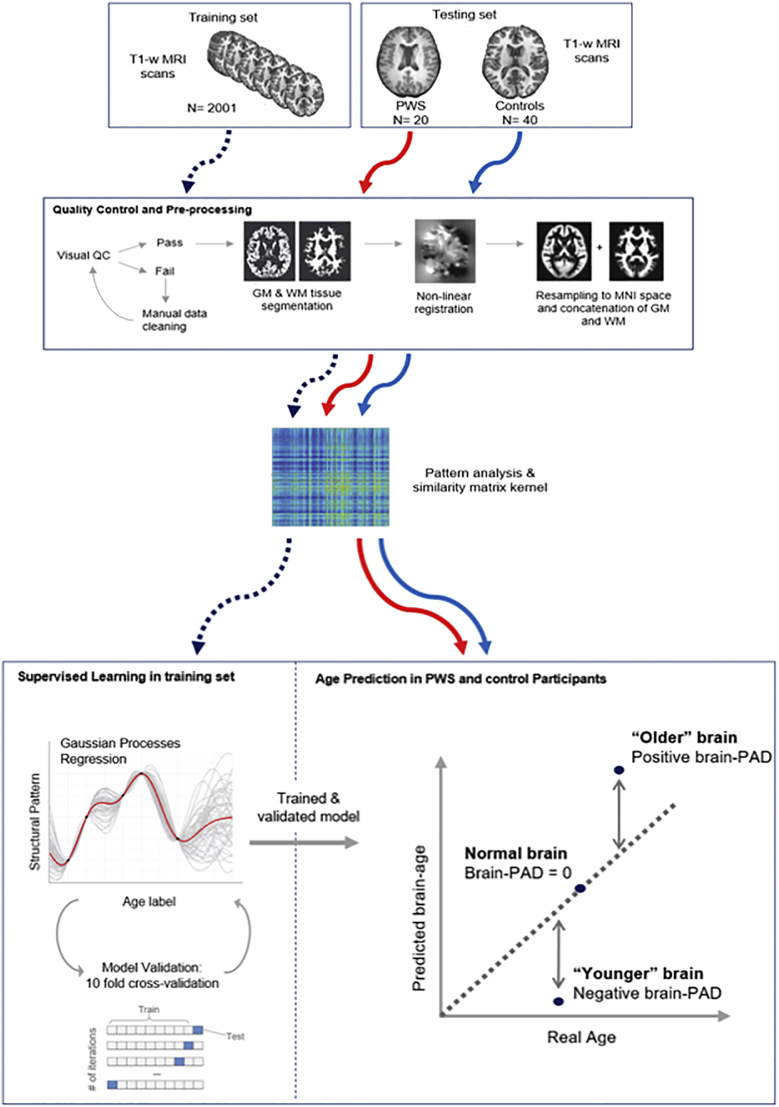
Outline of methods for brain-age prediction using machine learning.The data includes a training set and 2 testing sets (cohort1: controls vs. PWS; cohort 2: controls vs. SNORD116 microdeletion). The data was pre-processed using the Statistical Parametric Mapping software (SPM). The T1 images underwent tissue segmentation after initial quality control, separating GM, WM and CSF. The segmented images were then normalized using DARTEL for nonlinear registration, then resampled to the MNI152 template using a 4 mm smoothing kernel. GM and WM maps were concatenated into a single vector of data relating to brain size. All data underwent voxel-wise similarity analysis to generate a similarity kernel using PRoNTo. The training set was used to generate the brain-age model via supervised machine learning that produced a Gaussian Processes Regression (GPR) model trained to recognize structural patterns from imaging data associated with chronological age. The accuracy of the model generated from the training set was assessed using a 10-fold cross-validation method whereby 10% of samples were used for testing in all possible iterations to generate age predictions on all samples. The trained and validated GPR model was applied to the two test groups.